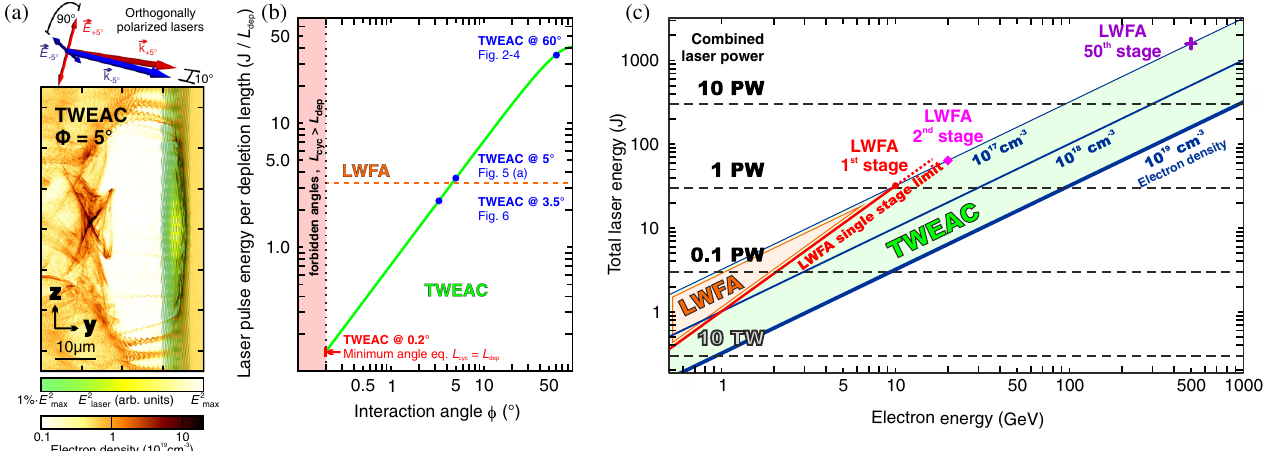
FIG. 5. (a) The TWEAC cavity at shock injection using laser pulses at 5° incidence angle, both linearly polarized, but orthogonally oriented with respect to each other in order to avoid transmissive plasma modes through standing waves in the laser field. All other initial conditions are kept the same as in Fig. 4. (b) The characteristic wakefield-driver energy of TWEAC [green line, W Eqs. (2) and (4)] as well as LWFA (orange, dashed line), with the blue markers referring to the respective TWEAC simulations.